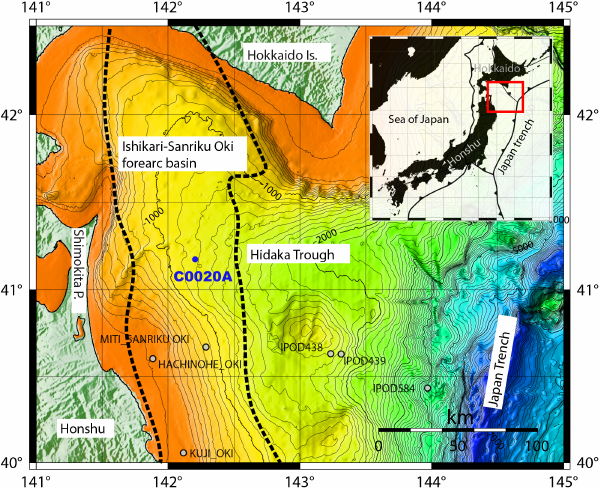
Figure 1. Bathymetric map of IODP Site C0020 (JAMSTEC Site C9001) and existing drill holes off the Shimokita Peninsula, Japan. Inset map shows plate configuration around Japanese islands and the location of the index map (gray square). This figure is slightly modified from Fig. S1 in Inagaki et al. (2015), and reprinted with permission from American Association for the Advancement of Science